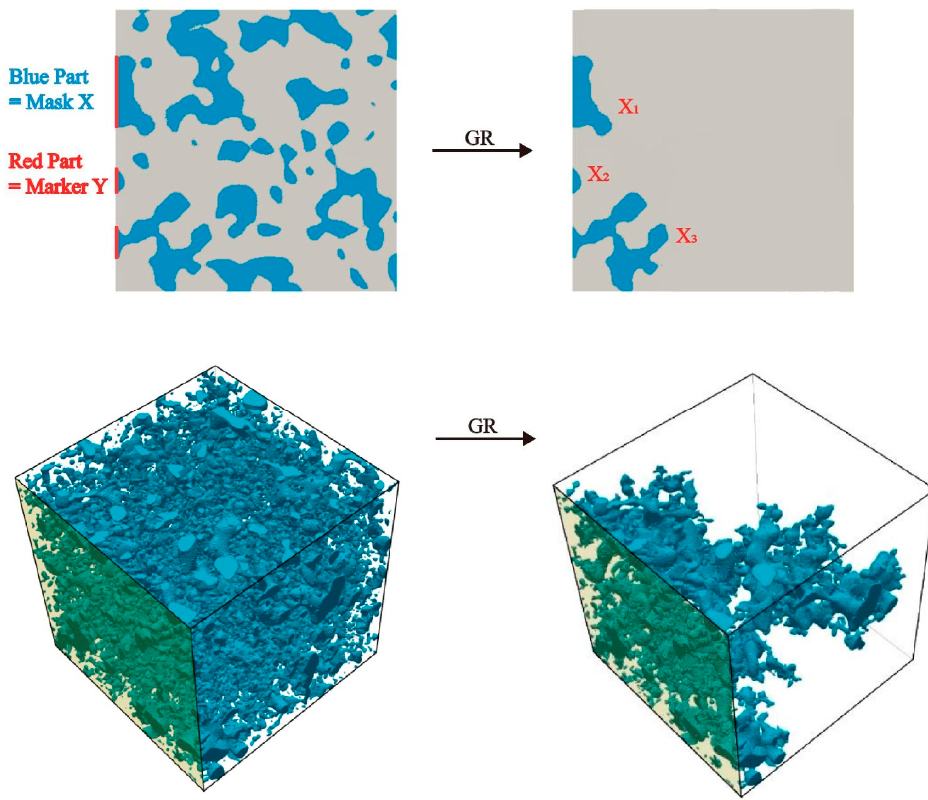
Figure 8. Operation of GR.